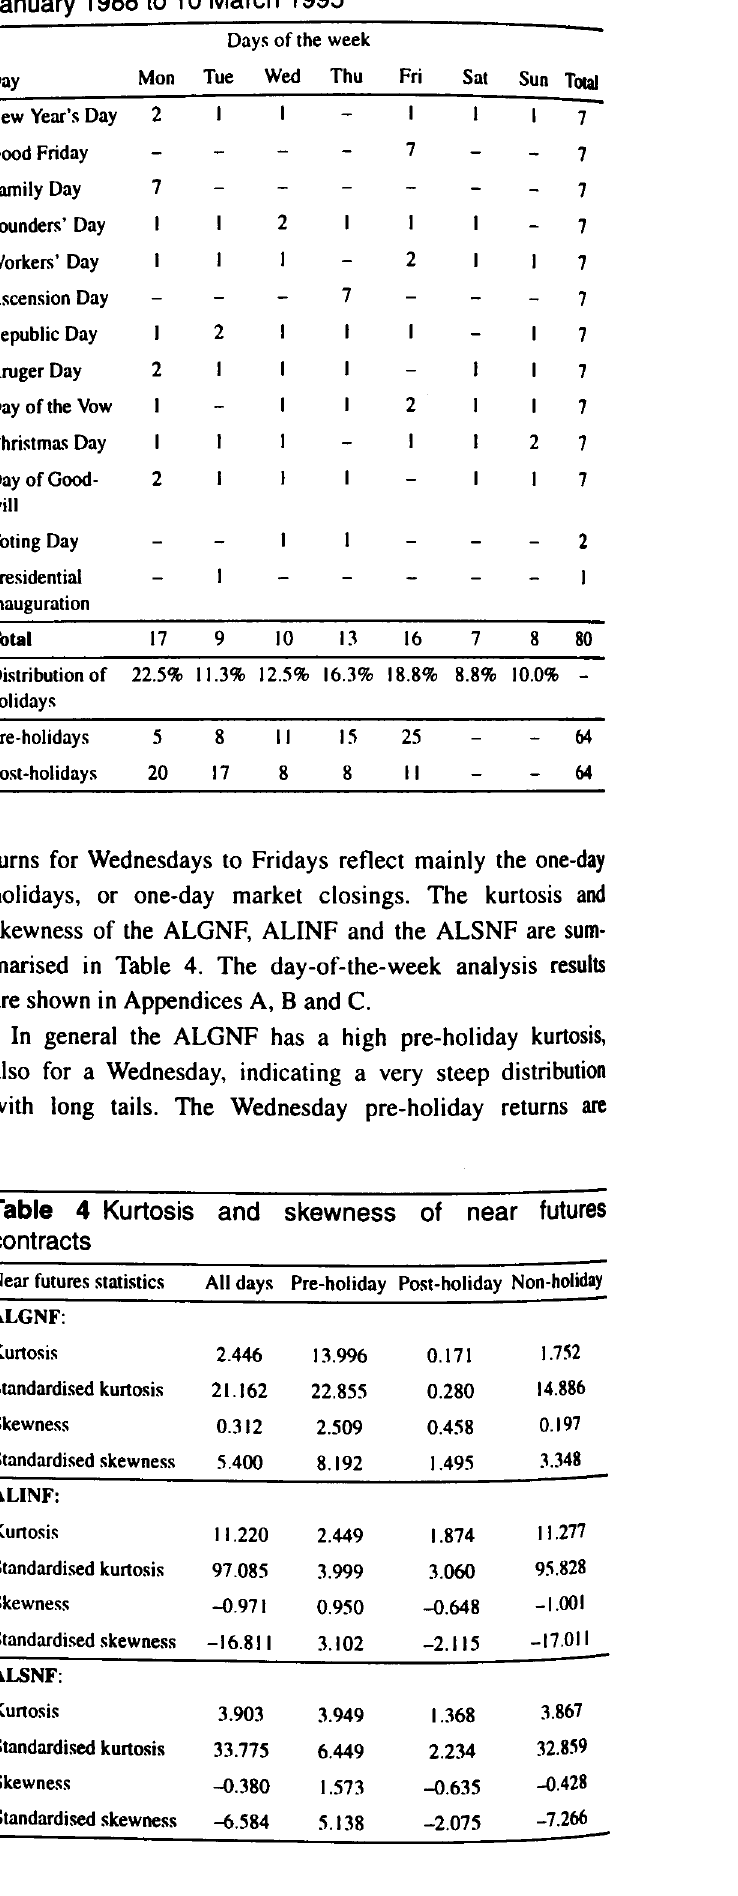
Table 2 Incomplete data and weekend holidays